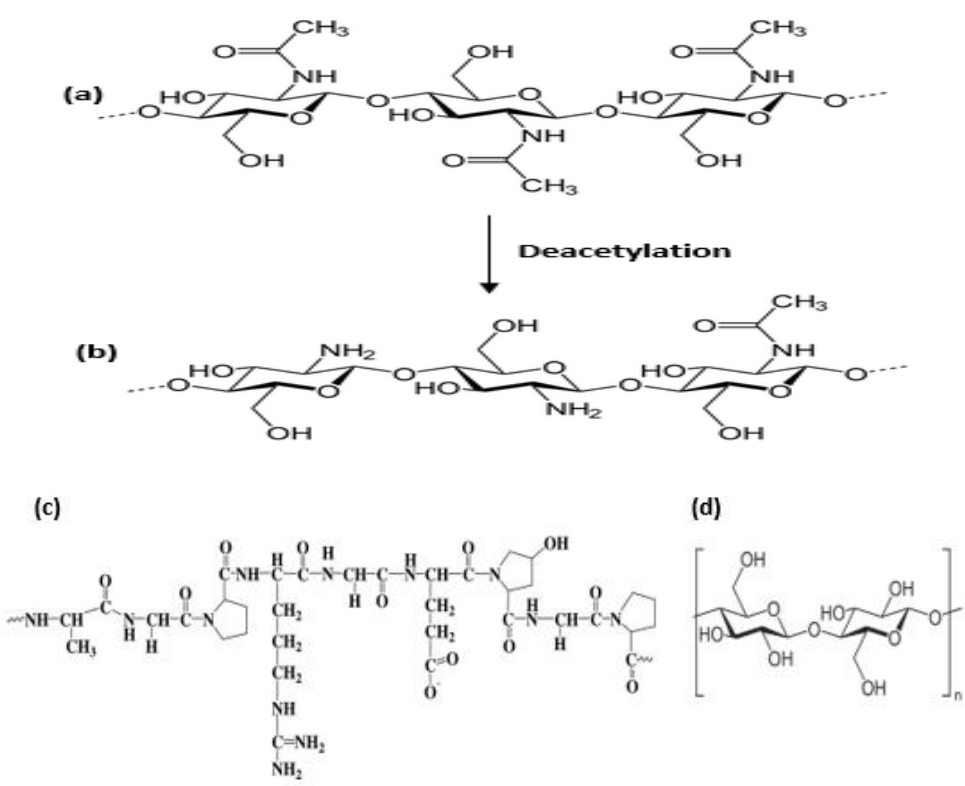
Figure 2. Polymer structure of ( a ) Chitin ( b ) Chitosan ( c ) Gelatin ( d ) Cellulose.